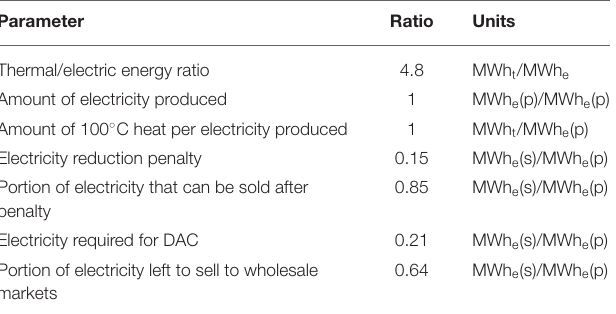
TABLE 3 | Energy distribution metrics for nuclear power plant co-located with DAC.